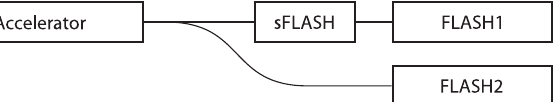
FIG. 1. Schematic layout of the FLASH facility. The super- conducting linear accelerator delivers electron bunches for the FLASH1 and FLASH2 undulator beam lines and for the seeding experiment